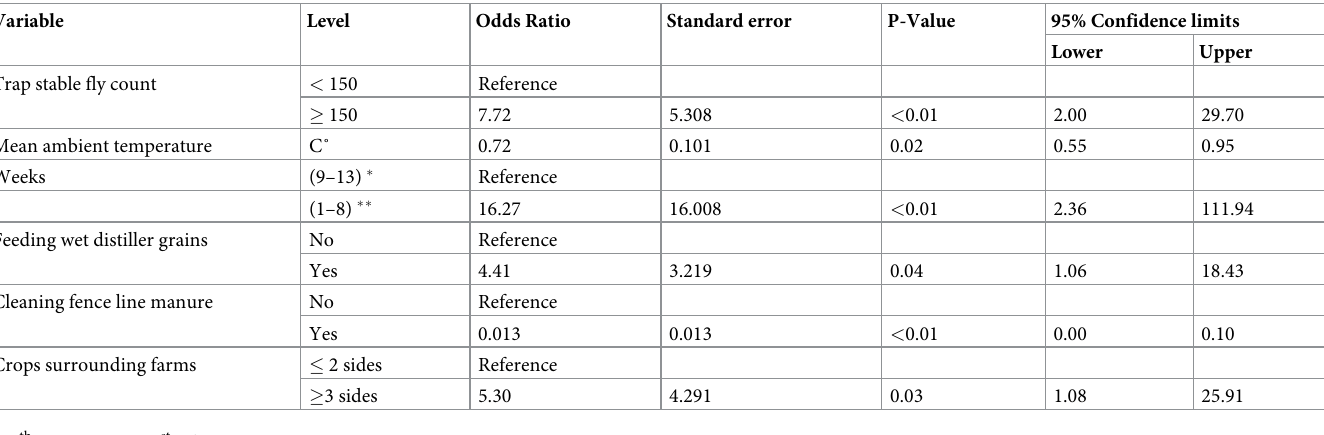
Table 4. Final generalized linear mixed model with logit link predicting cow bunching at the dairy level using trap Stable fly counts on 20 California